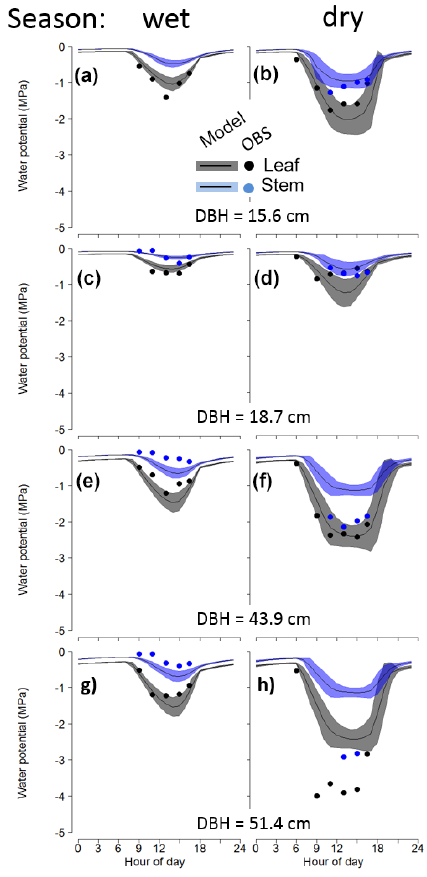
Figure 11. TFS v.1-Hydro simulated and observed diurnal varia- tion in leaf and stem water potential for individual trees subject to seasonal variation in water availability at Caxiuana National For- est, Brazil. Simulated trees possess identical trait values equal to the plot mean and were matched with observed trees based on size (DBH) (see Table 3). Trees are in order from smallest to largest, top to bottom, and are the following trees given in Fisher et al. (2006): (a–b) tree C1, (c–d) tree C2, and (e–f) tree C4.